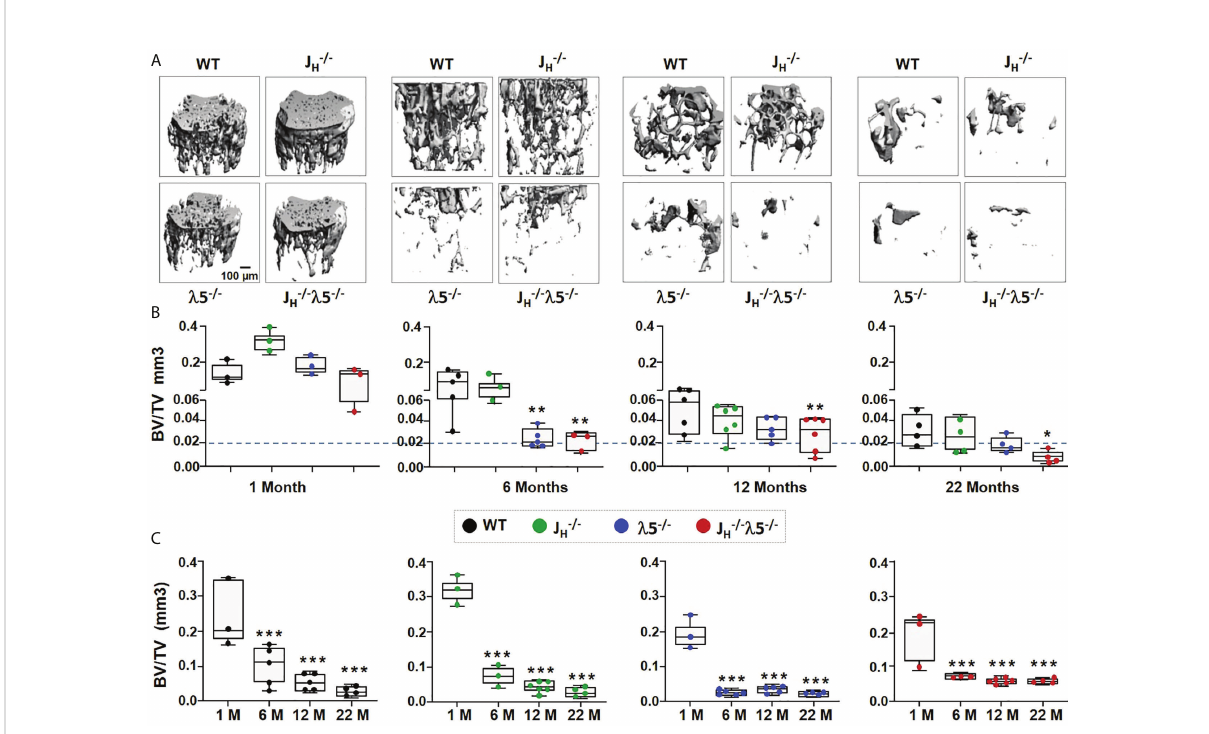
FIGURE 4 Absence of l 5 accelerates age-associated trabecular bone loss. (A) Representative 3D reconstruction of µCT images of trabecular bone from femurs of WT, J H-/- , l 5 -/- and J H-/- l 5 -/- female mice at one-, six-, twelve- and twenty-two-months of age are shown. (B) Graph shows quanti fi cation of trabecular BV/TV during post-natal development for indicated genotype. The blue dashed line represents the level of trabecular BV/TV of six-month old l 5 -/- mice compared to other genotypes. (C) The relative ratio of trabecular BV/TV of WT, J H-/- , l 5 -/- and J H-/- l 5 -/- mice at one-, six-, twelve- and twenty-two-months of age. Data were obtained from n=3-6 mice per group. Statistical signi fi cance relative to WT mice was calculated by ANOVA. *p<0.05, **p<0.01, ***p<0.001. Scale bar: